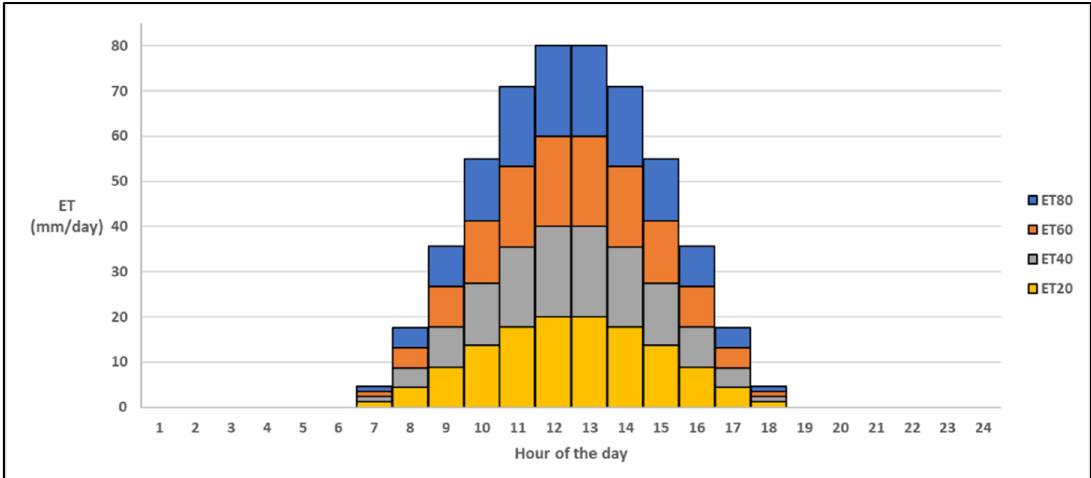
Figure 2. Daily schedules of evapotranspiration pumping rates in the vegetated zones of the model. Schedules are color-coded according to the maximum pumping rate (mm/day) achieved in each schedule, and labeled in shorthand (e.g., ET80 = maximum rate of 80 mm/day).